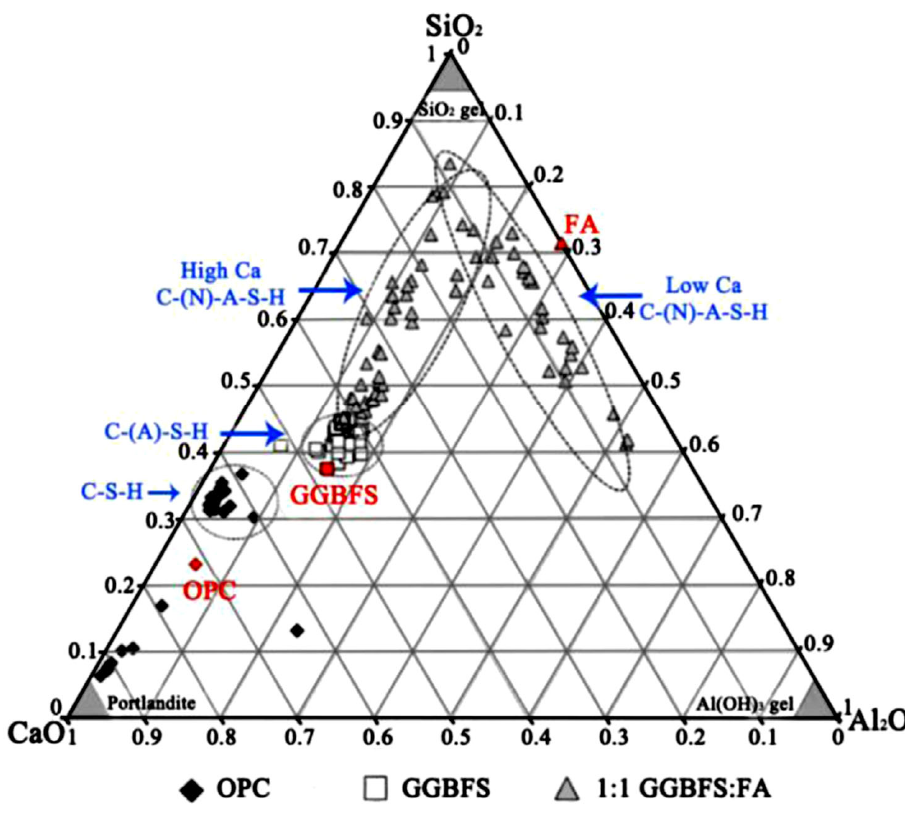
Figure 28. GP and PC binder gel compositions. Adapted from [66].